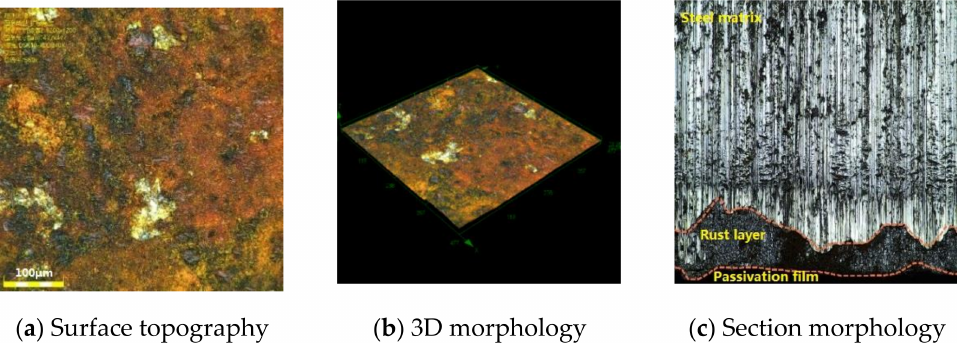
Figure 11. Morphology of rusty steel plate coated with water VDC-MA film ( × 560).